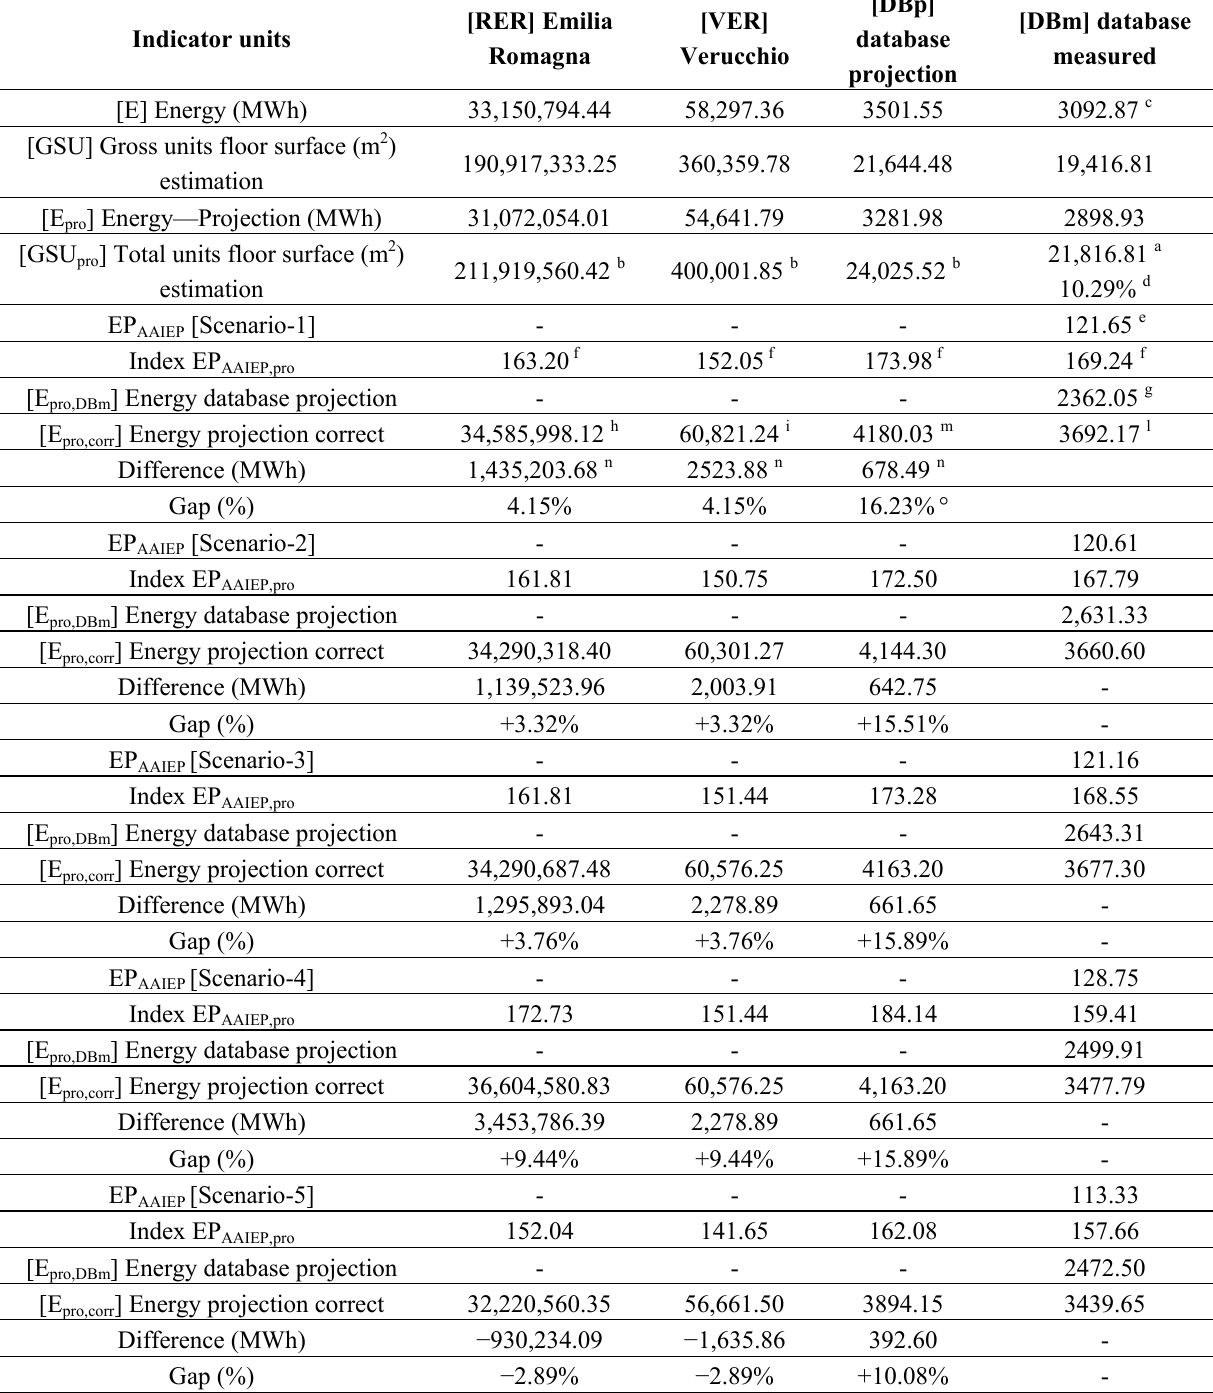
Table 10. Energy and statistical indicator for each of the